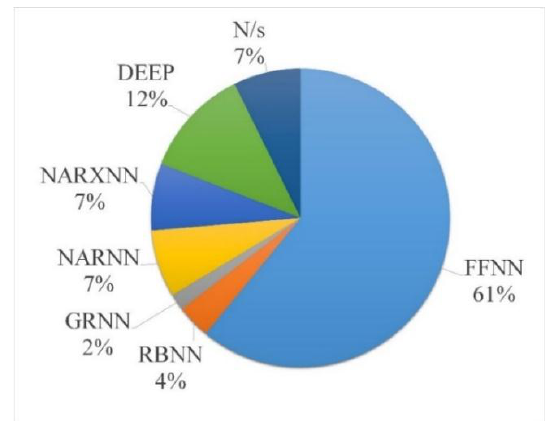
Figure 6. Percentage breakdown of the variety of ANNs applied.